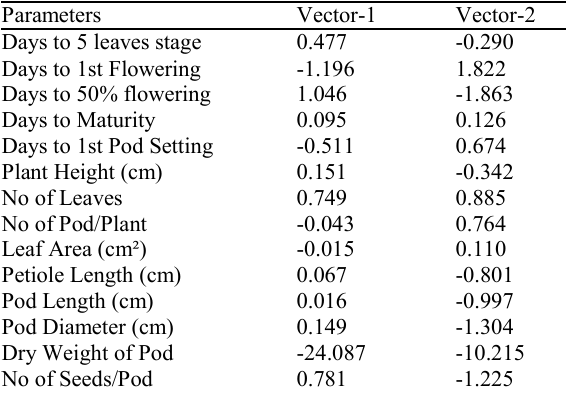
Table 6. Relative contributions of different characters to the total divergence of kidney bean